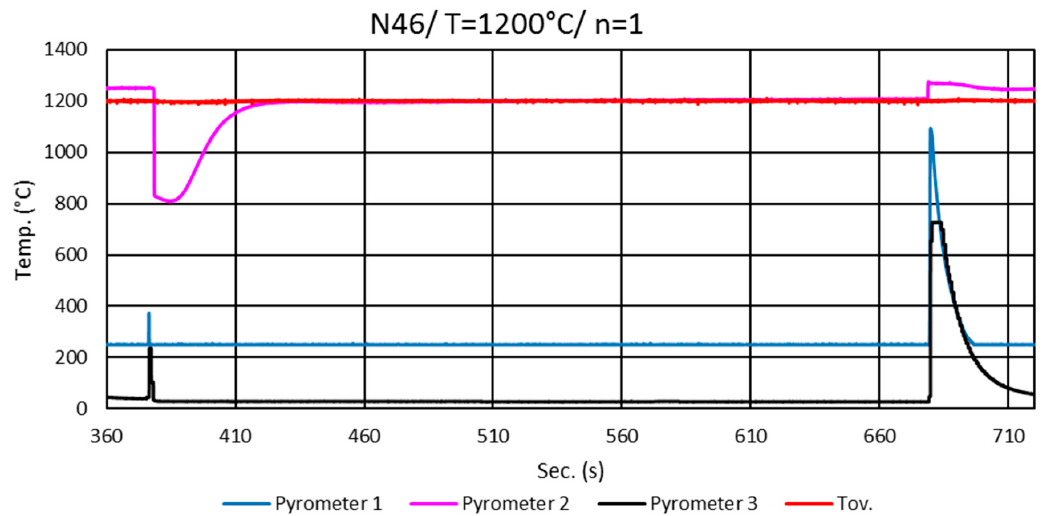
Figure 10. Thermal shock tests. The red line (TCup)—represents the recorded temperature of the oven by the Pt / PtRh thermocouple mounted inside the oven; magenta line (Pyrometer 2) represents the temperature of the sample over the heating stage during the test, which shows a peak starting from low temperature and a stabilized temperature for dwell time. The blue and black lines represent the temperature change of the sample over the cooling stage by Pyrometer 1 and Pyrometer 3, respectively.